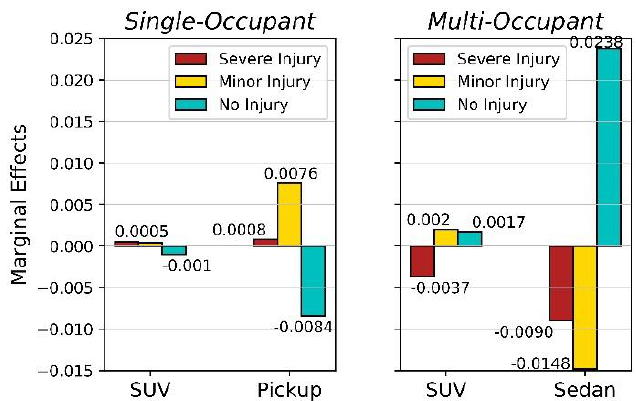
ff ects of Vehicle Characteristics. Figure 4. Estimated marginal effects of Vehicle Characteristics. Figure 4. Estimated marginal e